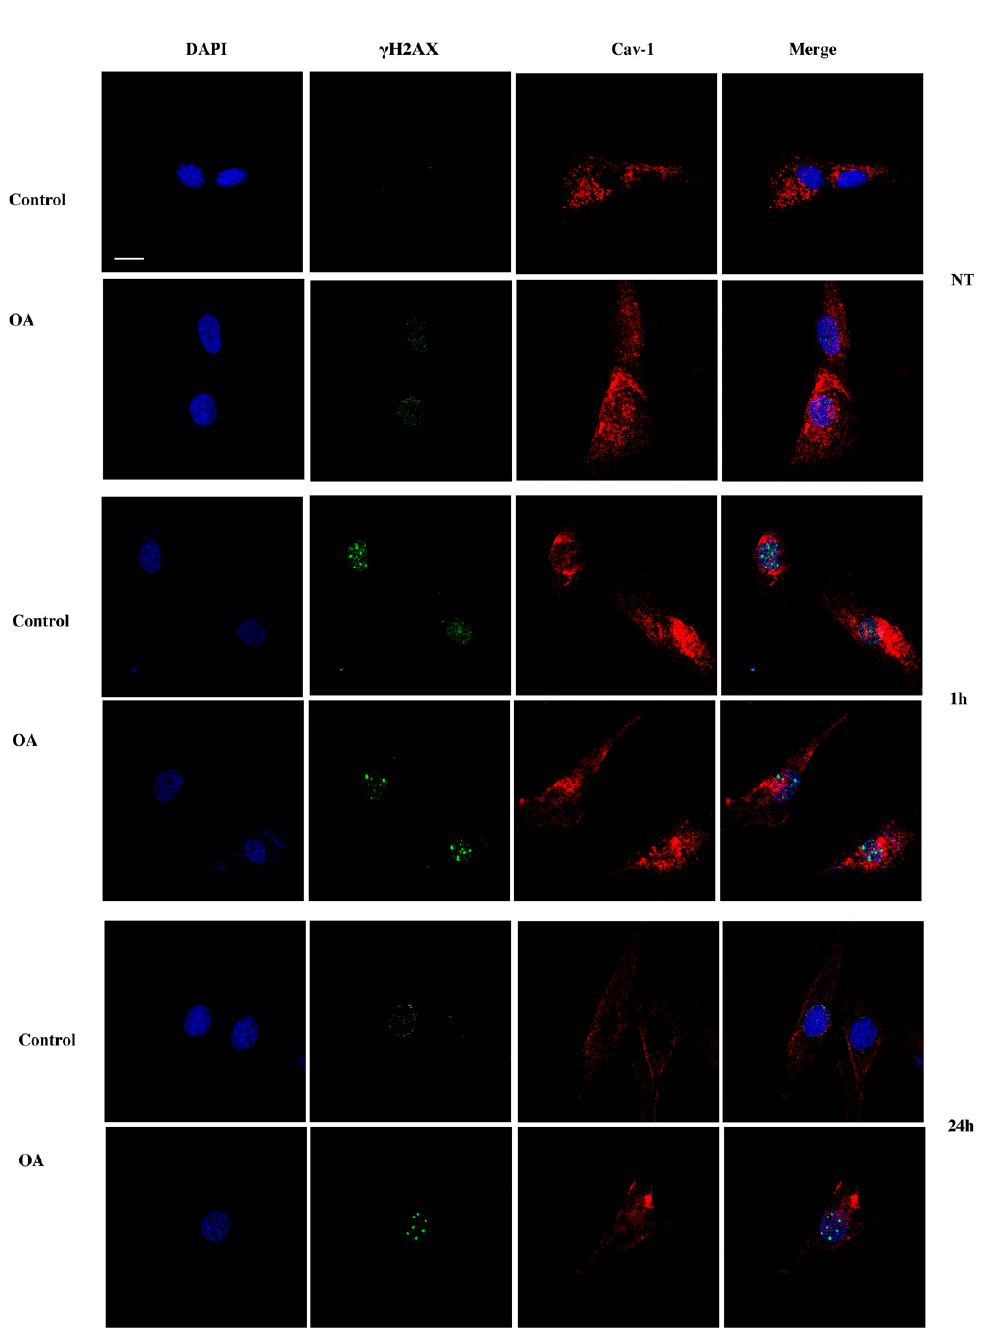
Figure 6. No translocation of caveolin-1 took place in osteoarthritic chondrocytes after exposure to exogenous oxidative insult. Characteristic images of the control and OA chondrocytes where caveolin-1 localization was evaluated by staining with anti-cav-1 antibody and the appropriate secondary antibody (red) under normal conditions (No Treatment—NT) and at 1 h and 24 h after being treated with H 2 O 2 . DNA damage was also assessed by staining with the γ H2AX antibody and the appropriate secondary antibody (green). Nuclei were stained with DAPI (blue). Images were captured with the 60 × objective lens of the ZEISS LSM 800 confocal microscope with Z stacks. Scale bar 25 µ